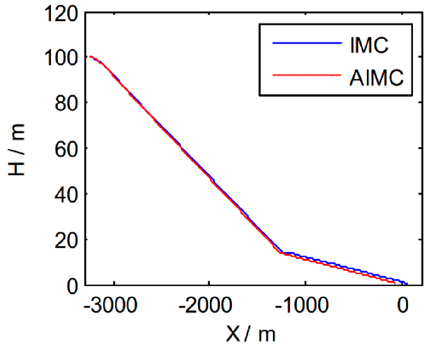
Figure 10. Hight in windward conditions.